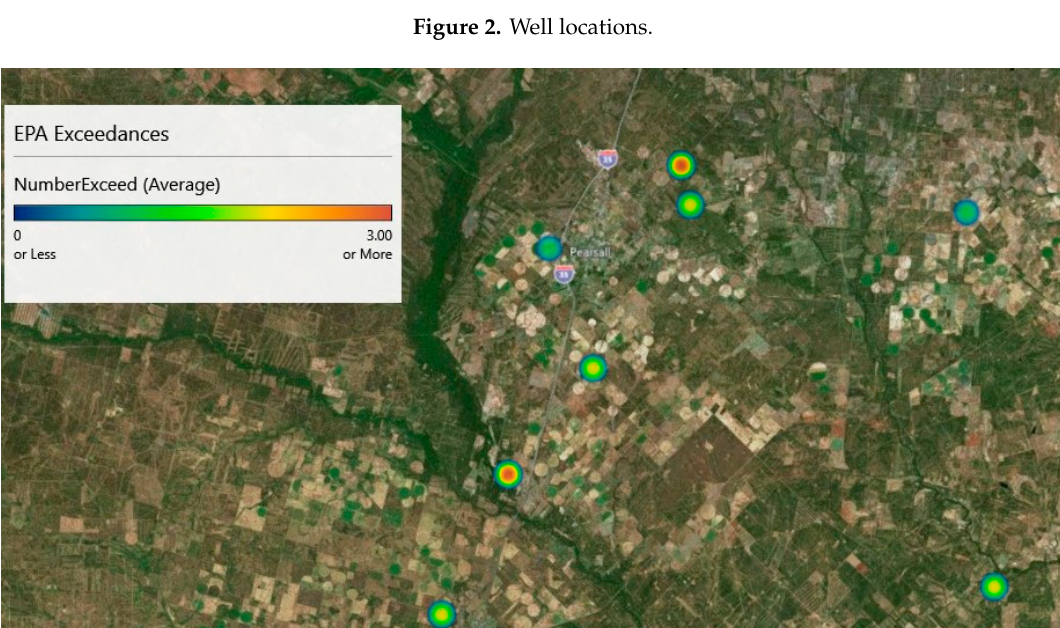
Figure 3. EPA exceedances heat map.